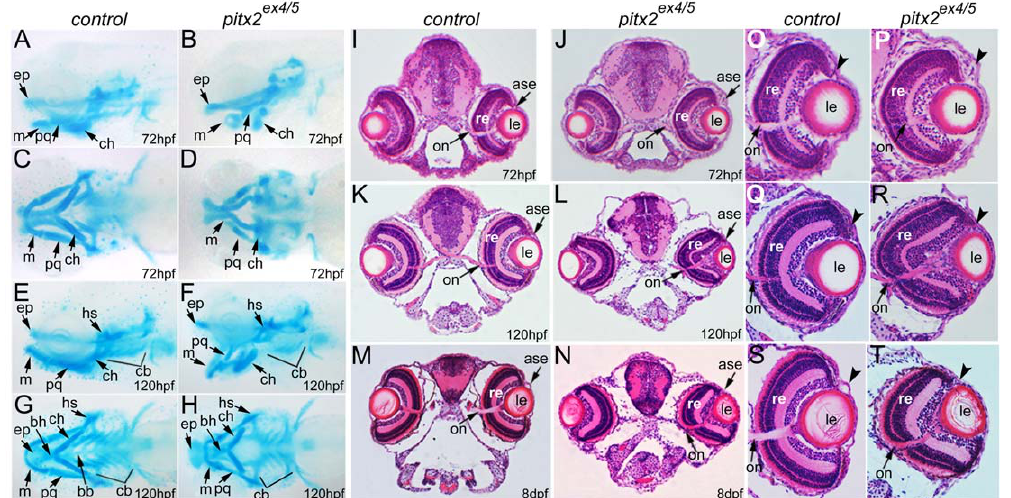
Figure 2. Deficiency of pitx2 results in craniofacial and ocular defects. A–H . pitx2 knockdown disrupts development of the pharyngeal arches. Lateral ( A, B, E, F ) and ventral ( C, D, G, H ) views of 72-hpf ( A–D ) and 120-hpf ( E–H ) larvae stained with Alcian blue. Numerous defects in the development of the lower jaw (anterior arches) and ceratobranchial (posterior) arches can be observed. I–T . pitx2 knockdown disrupts eye development. Representative images of histological sections of 72-hpf ( I,J,O,P ), 120-hpf ( K,L,Q,R ) and 8-dpf ( M,N,S,T ) control and pitx2 ex4/5 morphants; head sections at the optic nerve level are shown ( I–N ) as well as high magnification images for the eye ( O–T ). Please note the accumulation of cells in the anterior segment in 72-hpf pitx2 ex4/5 morphant embryos (arrowhead in P ) and abnormal eye size/shape in 120-hpf and 8- dpf morphants (arrowheads in R , T ). Abbreviations: A–H - bb,basibranchial; bh, basihyal; cb, ceratobranchial (P3–P7); ch, ceratohyal (P2); ep, ethmoid plate; hs, hyosympletic (P2); m, Meckel’s cartilage (P1); pq, palatoquadrate (P1); I–T - ase, anterior segment of the eye; le, lens; on, optic nerve; re- retina.